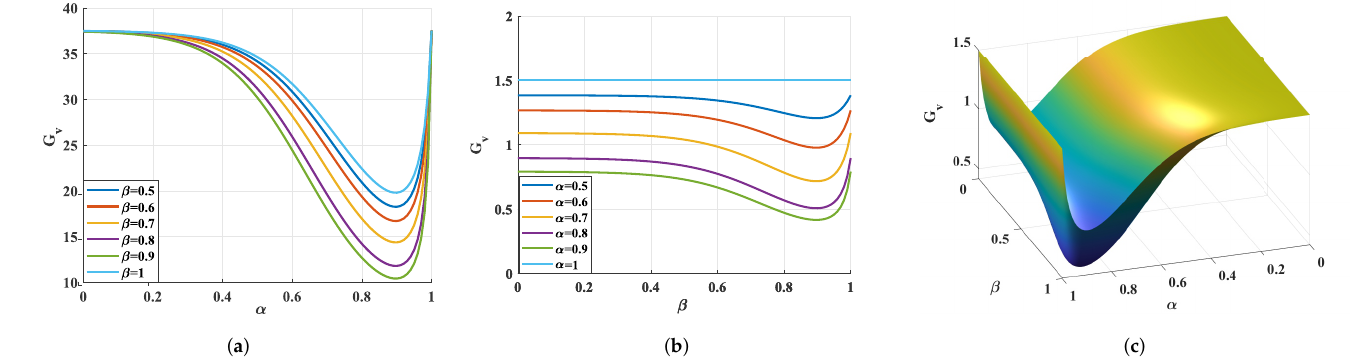
Figure 4. Visualization of α and β influence the response of G V in stable-state. ( a ) Relationship between G v and α . ( b ) Relationship between G v and β . ( c ) Three-dimensional representation of α and β